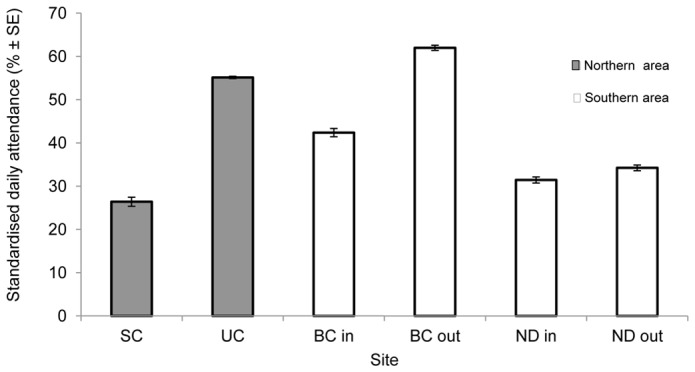
Standardised mean daily attendance of grey reef sharks in the monitored areas in Palau.Legends represent receivers at monitored site: SC =  Siaes Corner, UC = Ulong Channel, BC in =  Blue Corner Incoming, BC out =  Blue Corner Outgoing, ND in =  New Drop-off Incoming and ND out =  New Drop-off Outgoing. Ulong Sand Bar receiver is not included.